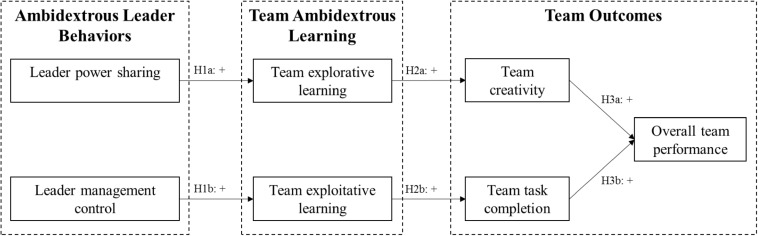
Hypothesized model.